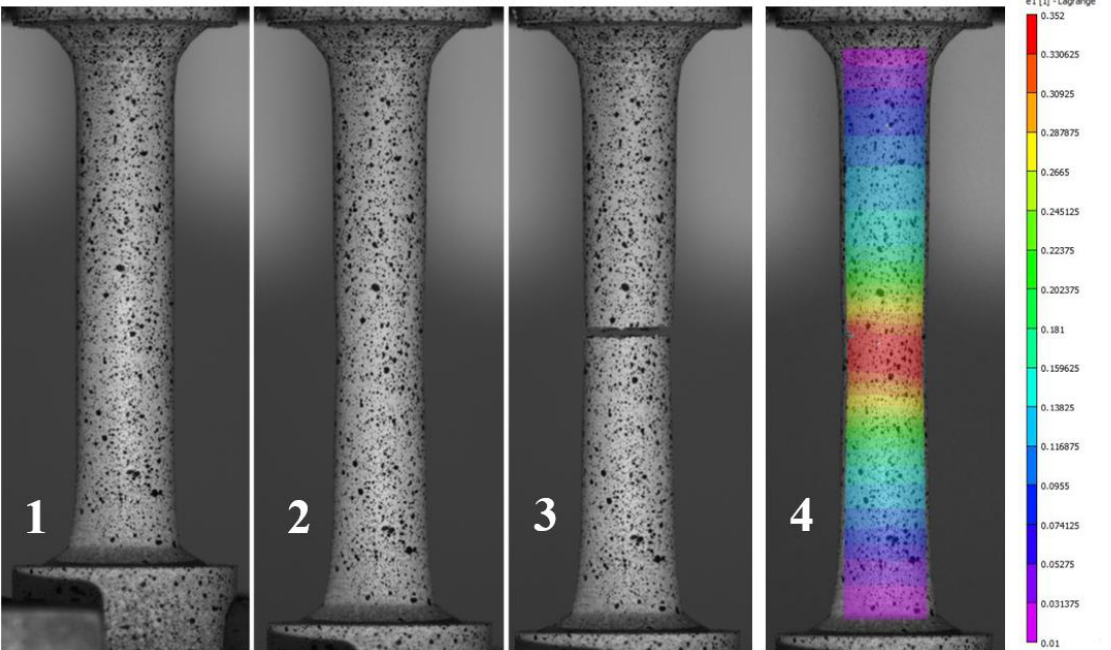
Figure 6. “D2” specimen under tension test. ( 1 ) Specimen before testing, ( 2 ) no necking prior to fracture, ( 3 ) specimen post fracture, and ( 4 ) the contour plot showing the Lagrange strain localization before fracture in red (maximum stain) and purple (minimum strain).